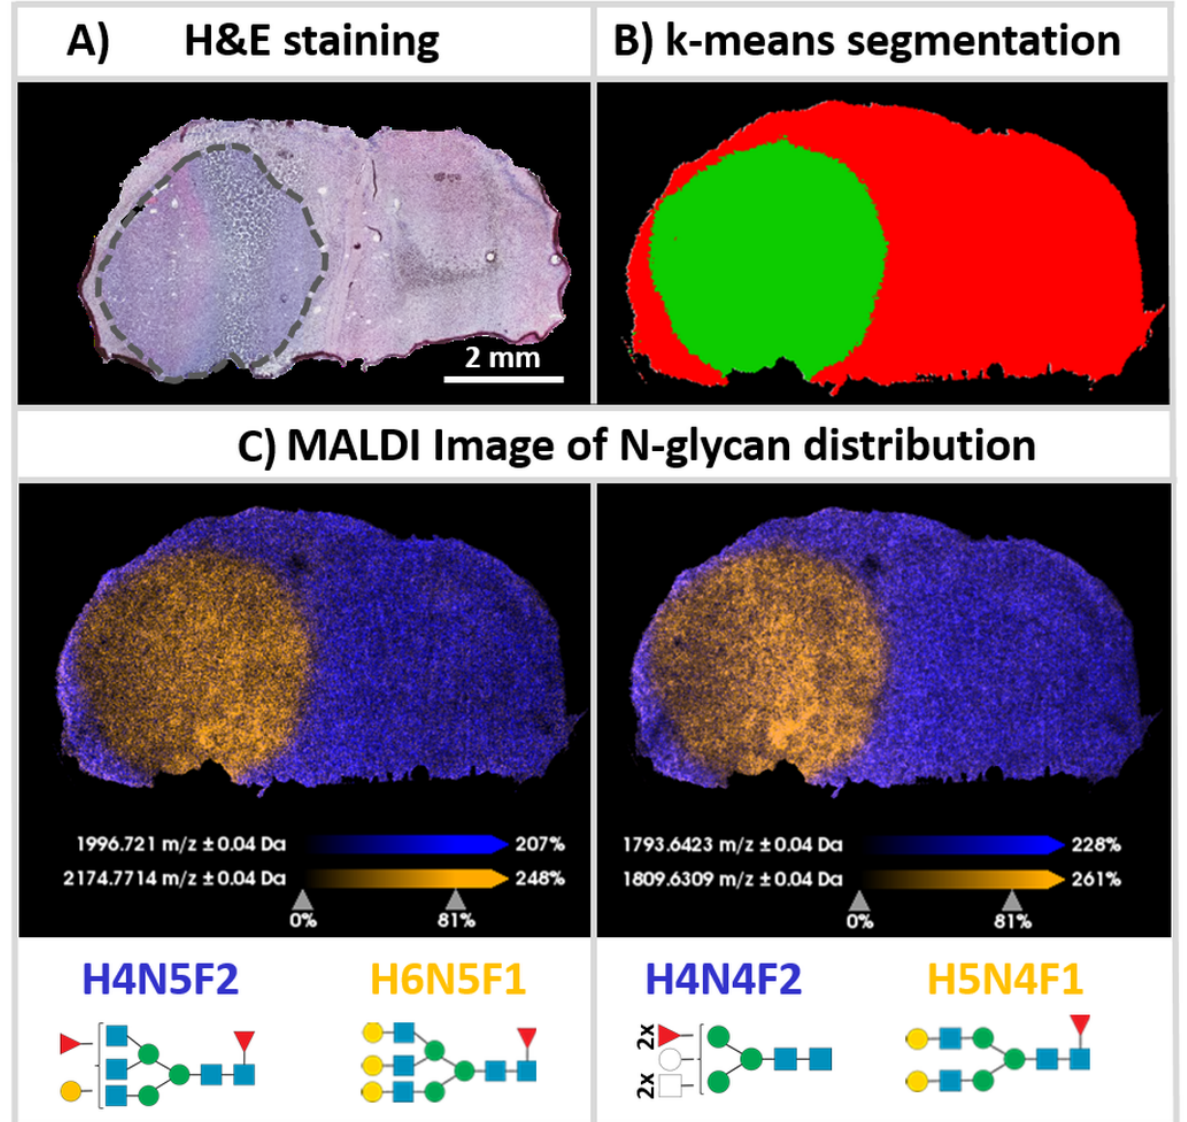
Figure 2. k-Means segmentation of mouse brains featuring tumors of human glioblastoma cell-derived xenografts. FF coronal sections of xenografted human U87 glioblastoma cells in CD1 nu/nu mouse brain were processed for N -glycan MSI. ( A ) H&E staining of an adjacent (and slightly distorted) tissue section. The black dotted line encircles the CDX tumor. ( B ) Result of k-means segmentation. ( C ) Orange segments indicate areas of xenograft tumor visualized by the m / z values of H6N5F1 [M + Na] + ( m / z 2174.7714) (left) or H5N4F1 [M + Na] + ( m / z 1809.631) (right), whereas purple corresponds to the non-tumor area represented by the m / z value of H4N5F2 [M + Na] + ( m / z 1996.721) (left) or H4N4F2 [M + Na] + ( m / z 1793.642). Table 1. Common N -glycans detected in human glioblastoma cell-derived xenografts ( n = 3).